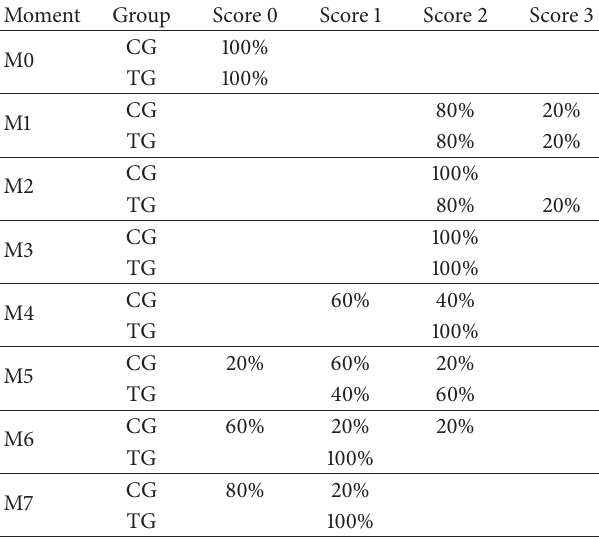
using the employed score system (animals